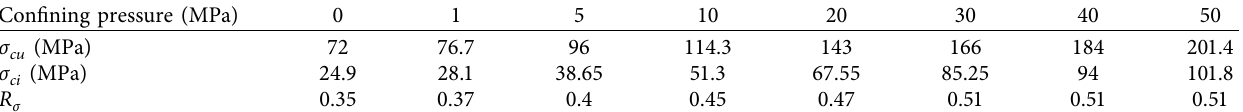
Table 4: σ ci and σ cu of rocks under different confining pressures.